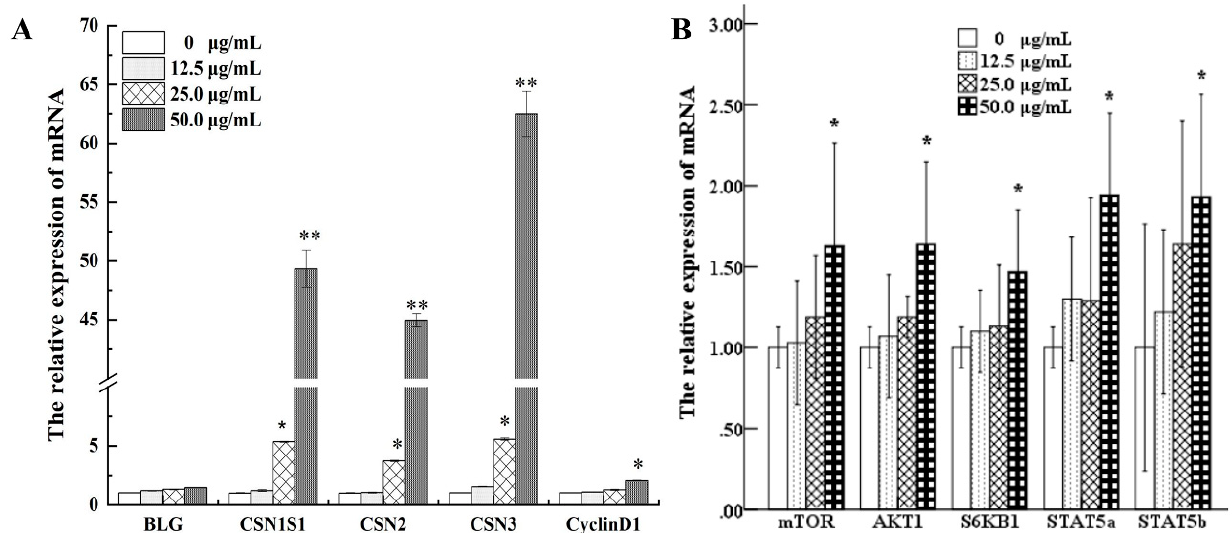
Figure 9. Effect of UEC4-1 on the expression of genes related to milk-protein synthesis. ( A ) The expressions of BLG, CSN1S1, CSN2, CSN3 and CyclinD1 in MCF-10A cells were detected using qRT-PCR; ( B ) Changes in the level of lactation- and signaling-related gene expression were detected using qRT-PCR. * significantly different from the control group at p < 0.05, ** significantly different from the control group at p < 0.01.